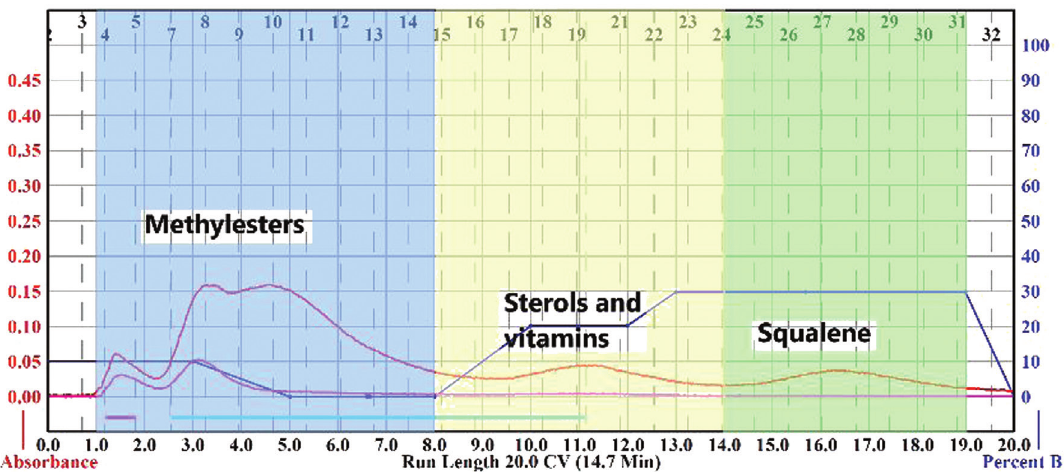
Figure 3: Chromatogram with a 26 g C-18 silica